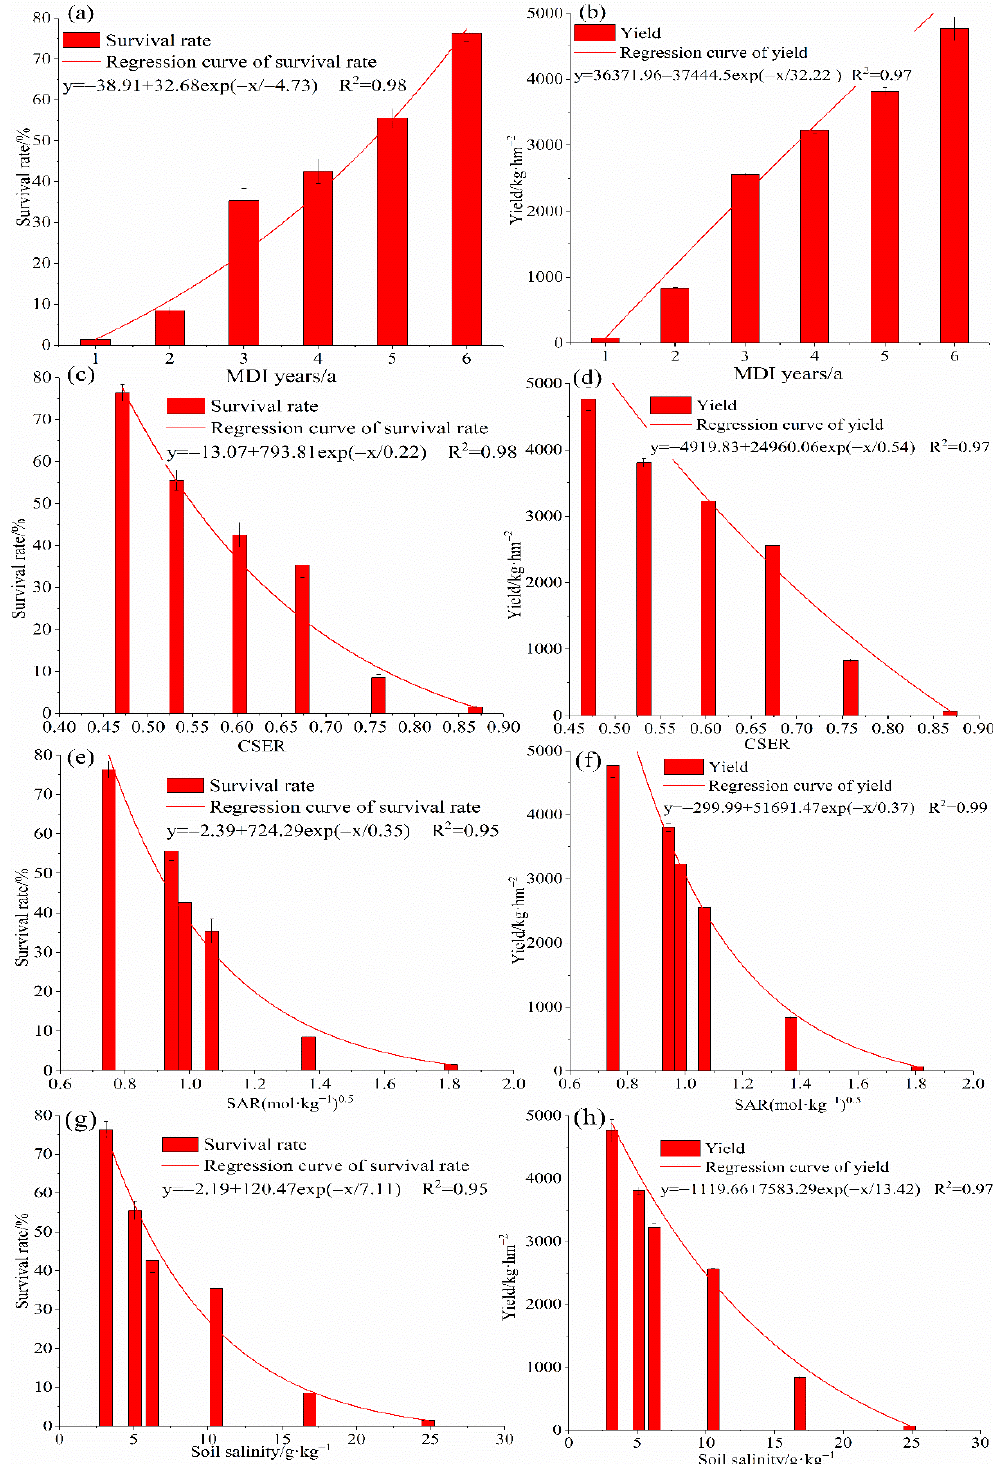
Figure 6. Cotton survival rate (Value ± SD) and yield(Value ± SD) change with the years of MDI ( a , b ), CSER ( c , d ), SAR ( e , f ), and average soil salinity ( g , h ) are represented by histograms, and the red curves are the regression curves of cotton survival rate and yield with long-term MDI, CSER, SAR, and average soil salinity, respectively.